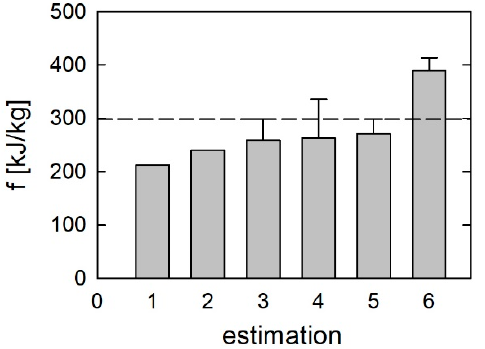
Figure 10. Estimated values of the force: 1: based on [8], 2: based on [4], 3: based on [7] (glass balls), 4: based on the extrapolation of the exponential part of pressure courses, 5: based on the maximum pressure values, 6: based on [10] (the dashed line is the black powder force).